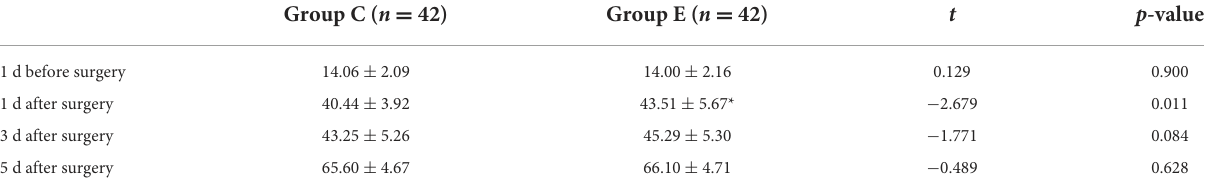
TABLE 4 Comparison of Harris of the two